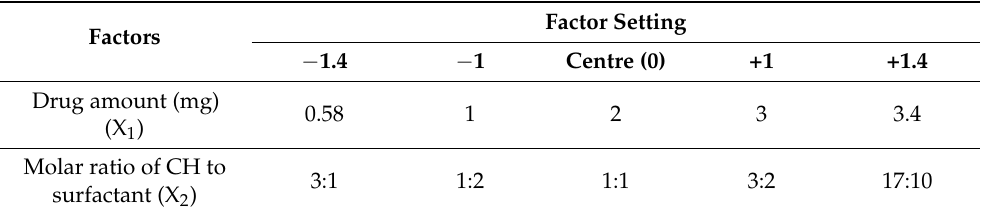
Table 2. Optimisation of epigallocatechin gallate (EGCG)-niosome by central composite design.